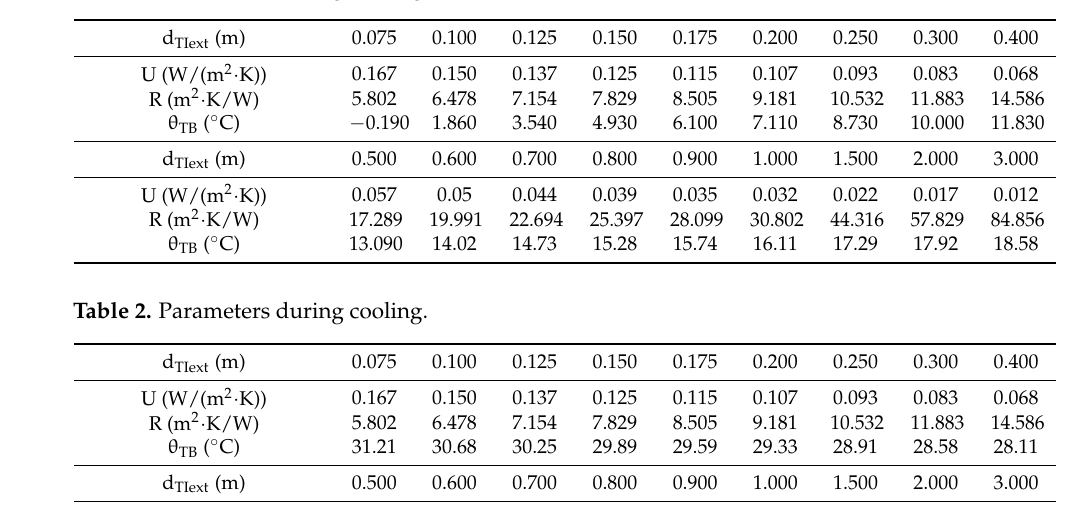
Table 1. Parameters during heating.